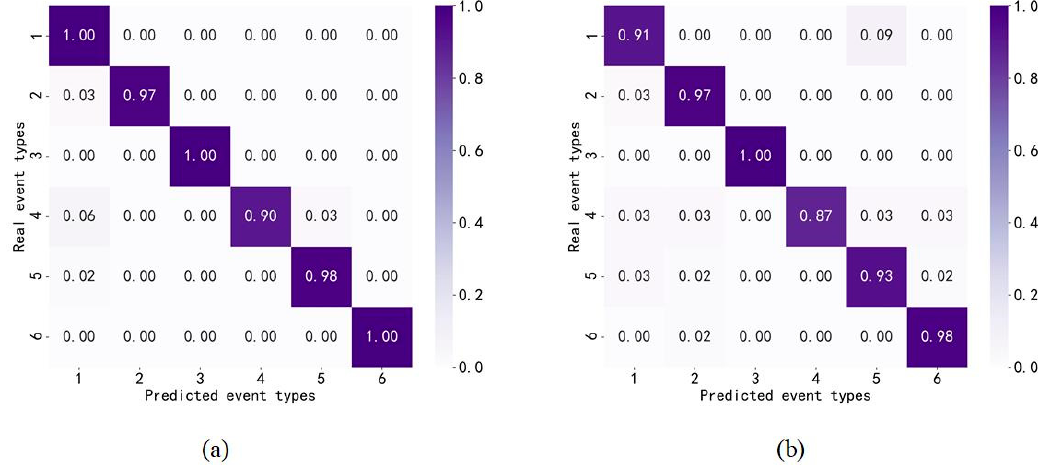
Figure 7. Confusion matrix of the two models, ( a ) VGG16 ‐ 1D, ( b ) VGG16 ‐ 2D.